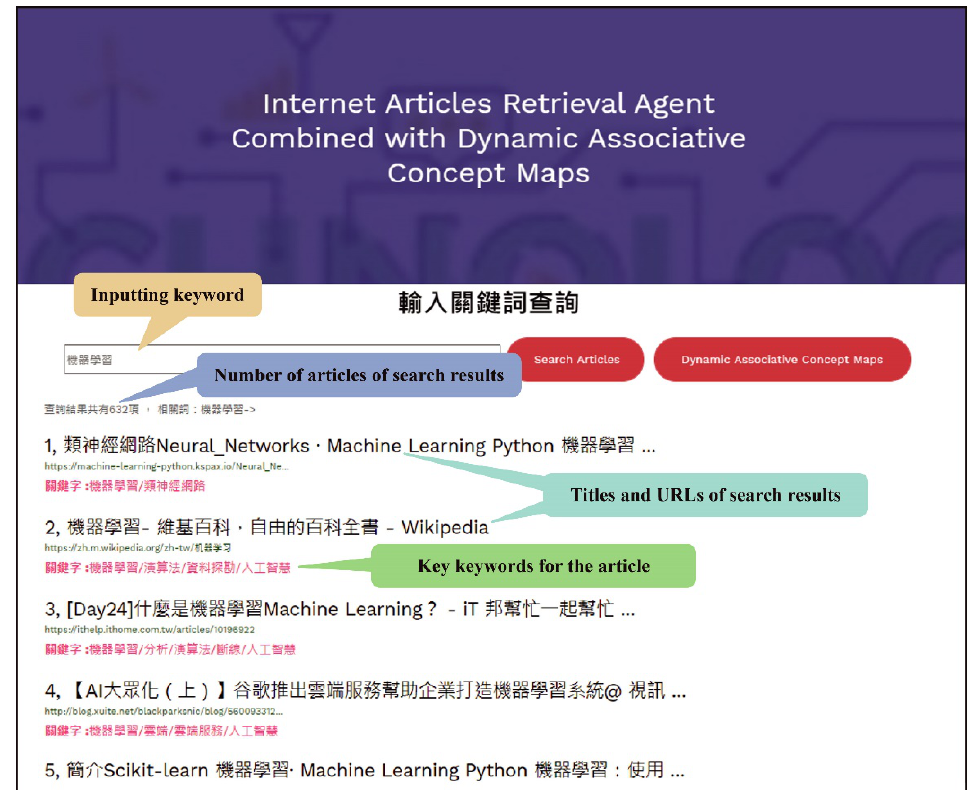
Figure 6 Operation Interface for the Internet Articles Retrieval